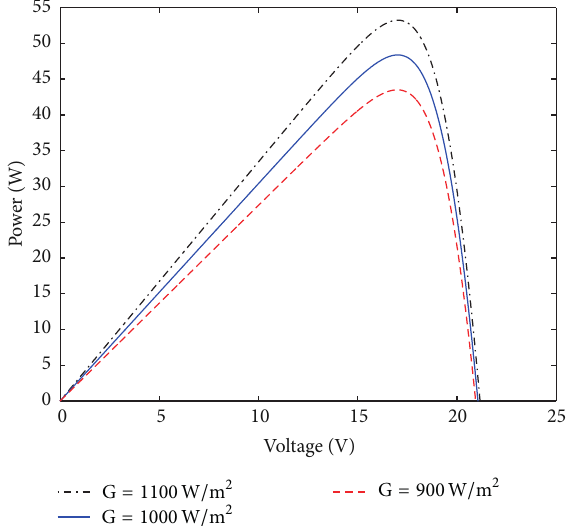
Figure 10: 𝑃 - 𝑉 chart of considered PV model for different irradia- tions (temperature = 25 ∘ C).